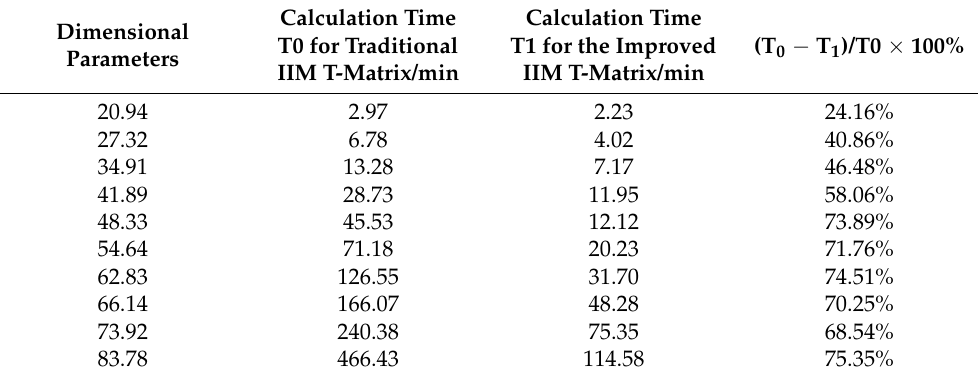
Table 6. Calculation time before and after optimization of hexagonal prism particle IIM T-matrix